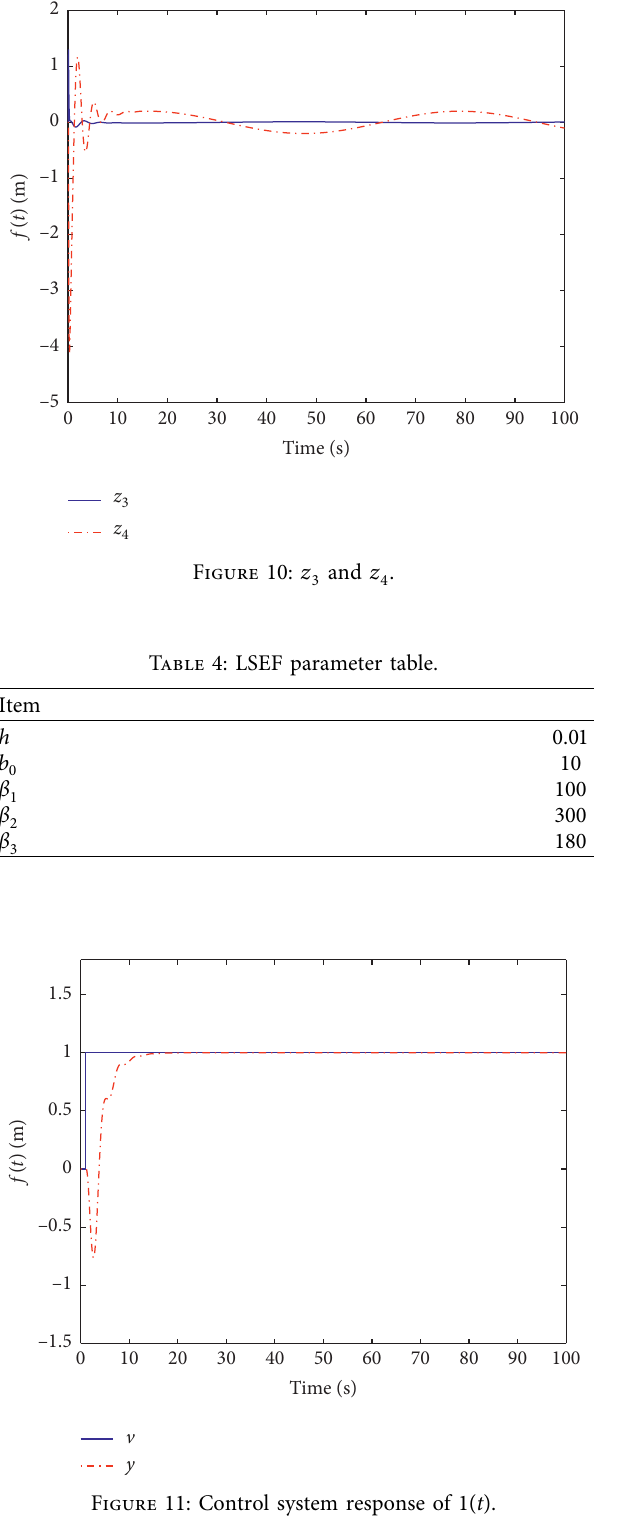
Figure 11: Control system response of 1( t ).